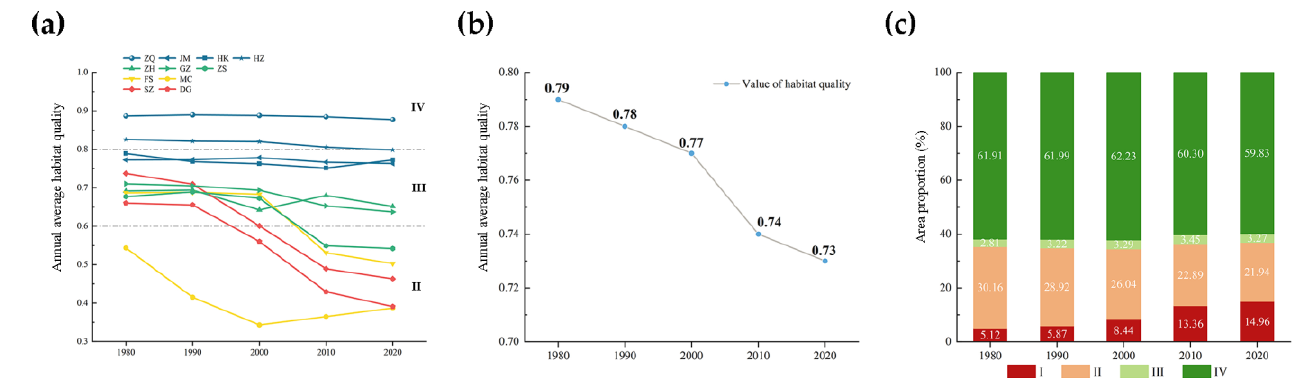
Figure 11. Temporal changes in habitat quality by city ( a ) (the different colors from top to bottom represent a decreasing range of habitat quality, i.e., <10%, 10–20%, 20–30%, >30% respectively), annual average value of habitat quality in the GBA ( b ), proportions of different habitat qualities in different grades ( c ).